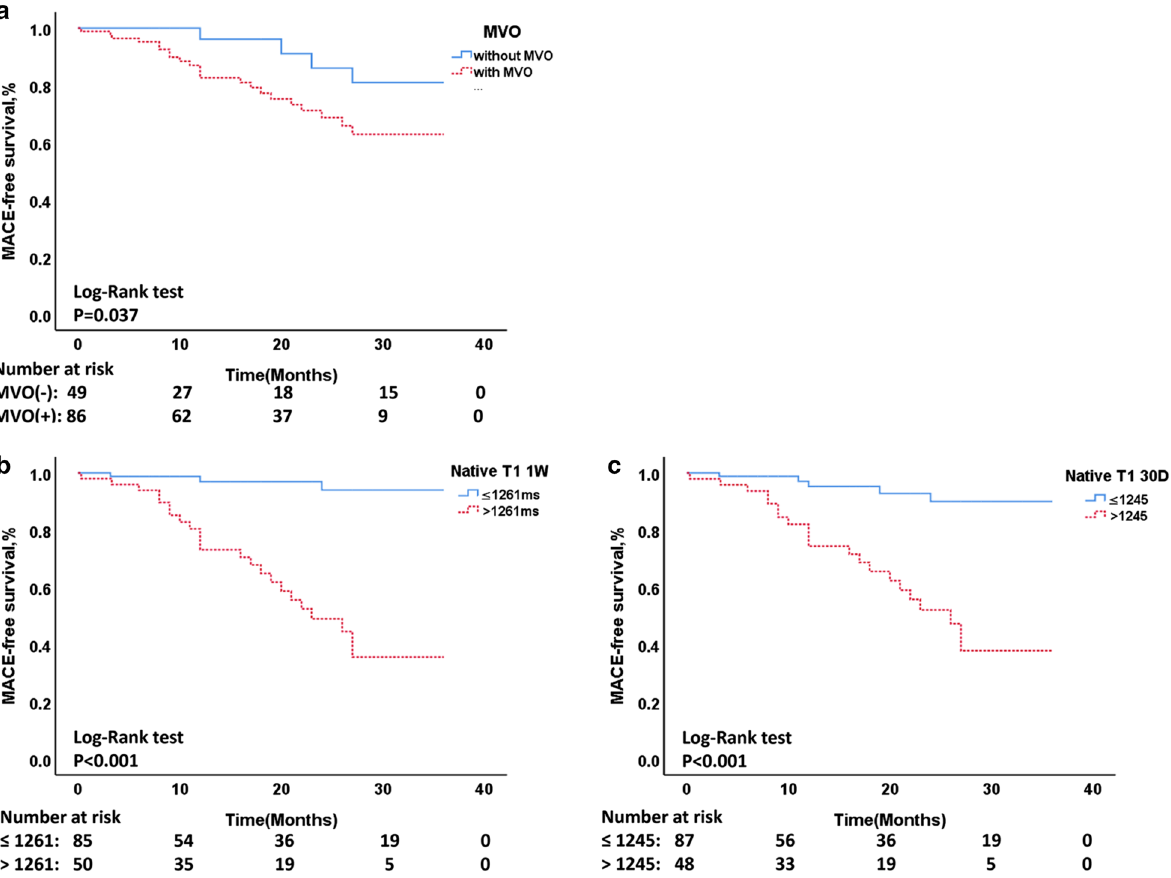
Fig. 4 Kaplan–Meier curve for the MACE‑free survival rate of three groups. a MVO present versus absent ( p